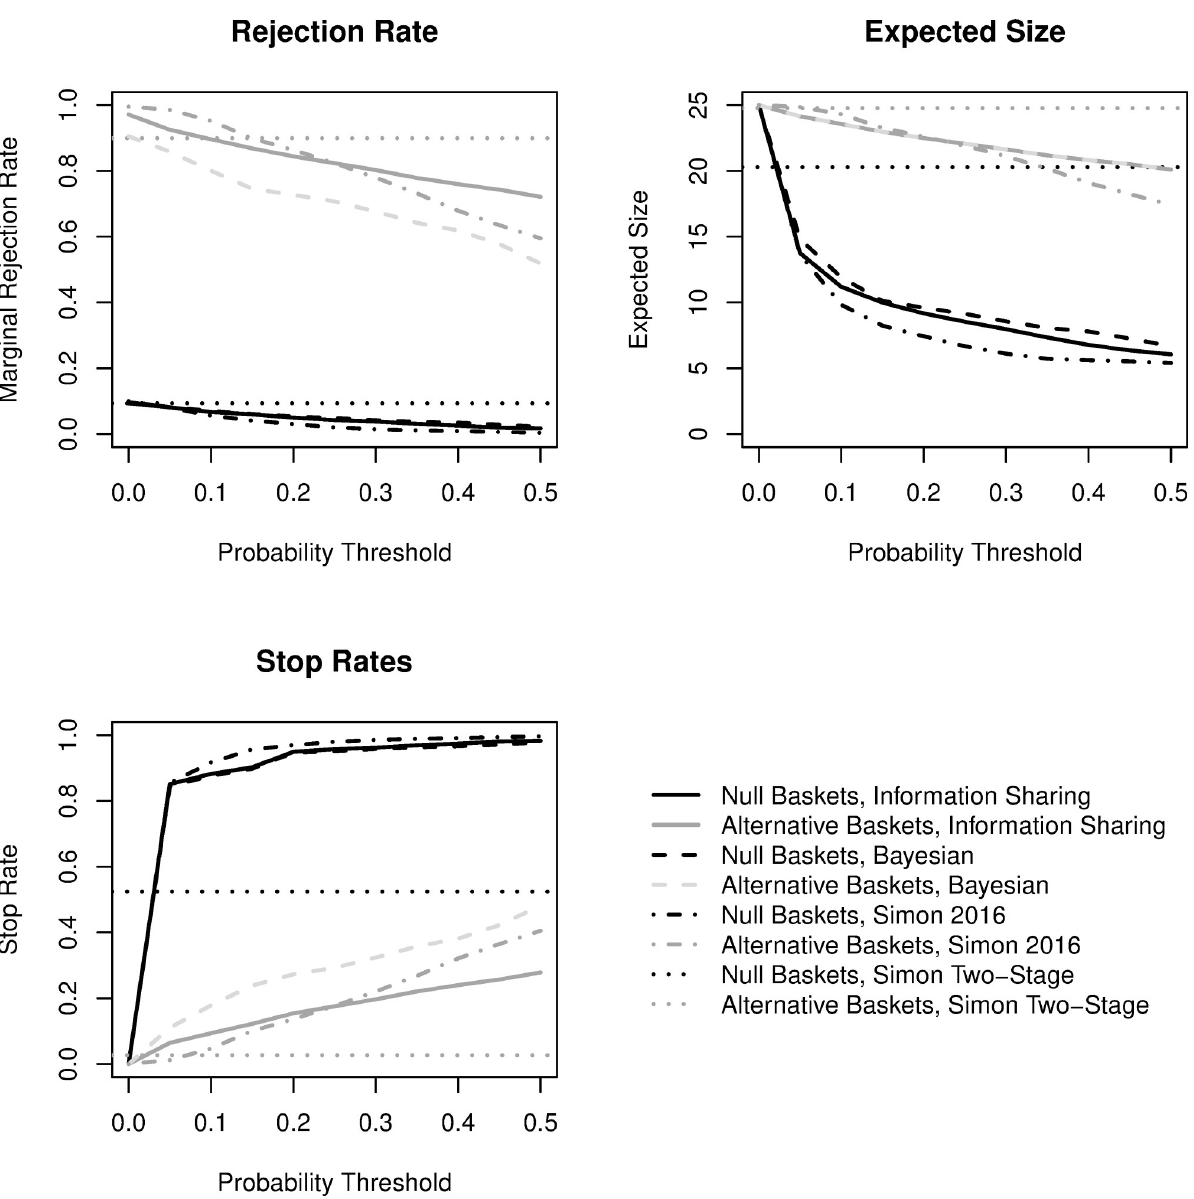
Fig 2. Comparisons of trial operating characteristics for global scenarios (all null or all alternative baskets). Black coloring is for null baskets and gray coloring for alternative baskets. The dotted lines represent Simon’s two-stage minimax design, dashed lines represent a design with interim monitoring after each participant based on Bayesian predictive probability futility monitoring, dashed-dotted lines represent Simon’s (2016) design with information sharing with posterior probability futility monitoring, and the solid lines represent a Bayesian design that also facilitates information sharing across baskets based on exchangeability of the response rate with predictive probability futility monitoring. The rejection rate summarizes the proportion of baskets across the 1000 simulated trials where efficacy was concluded, the expected sample size presents the average number enrolled in a given null or alternative basket, and the stop rate describes the proportion of baskets that terminated early at any point for